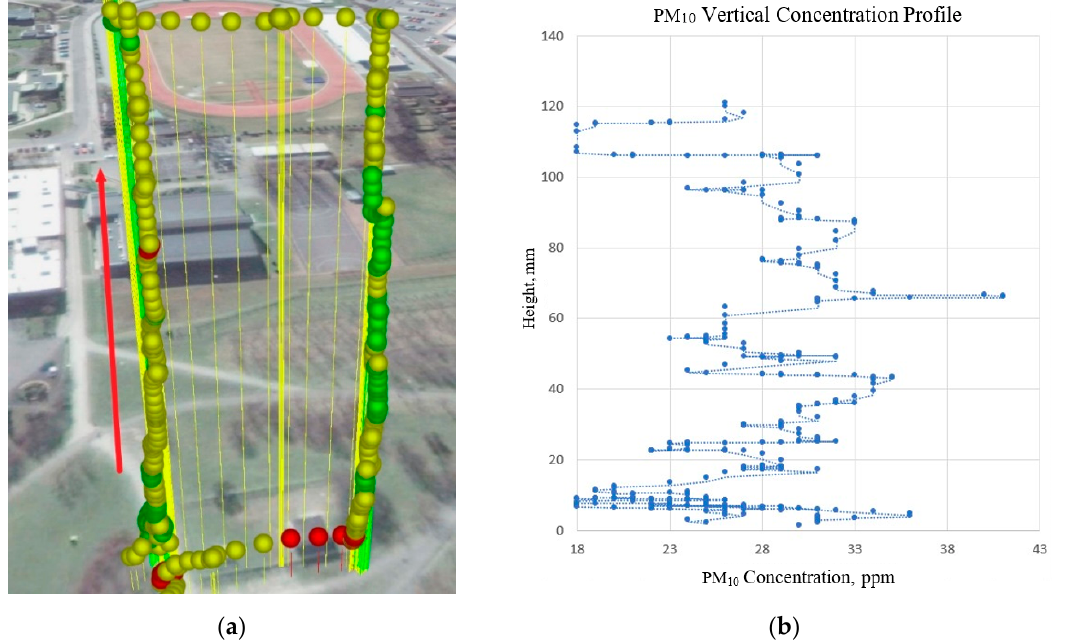
Figure 11. Flight route and measurement points visualization ( a ) for vertical concentration profile of PM 10 ( b ) for location number 2 (see Figure 1)—red arrow indicates ascending flight and data for the visualization chart.